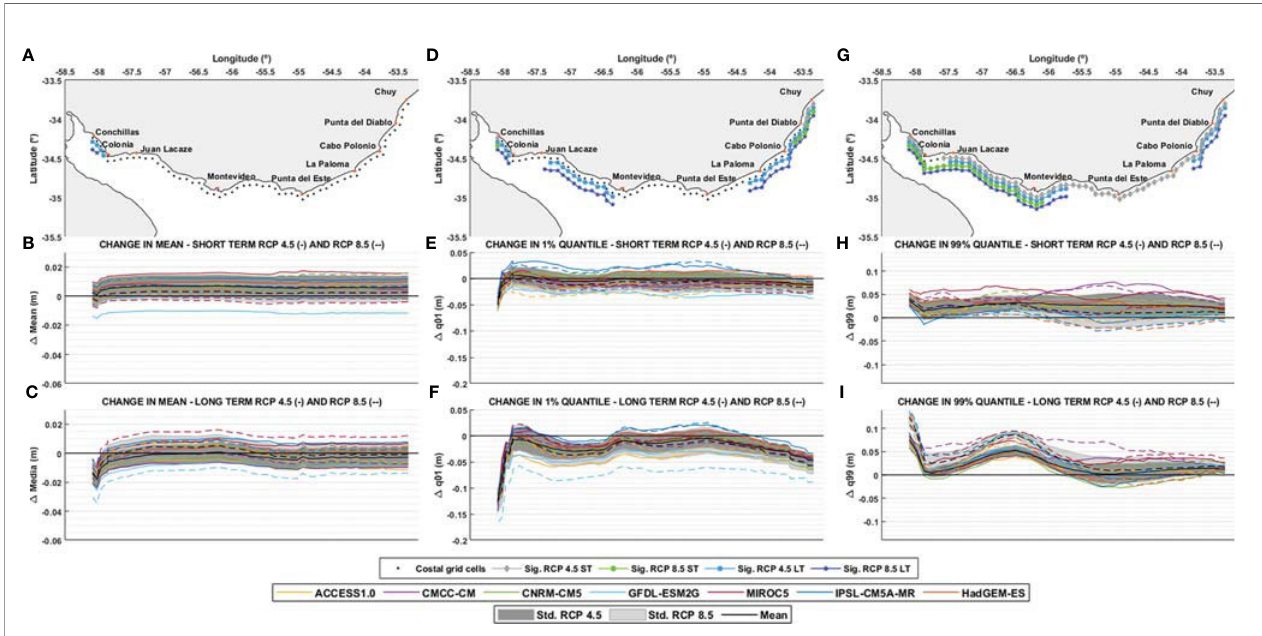
FIGURE 9 | Change in mean (A – C) , change in 1% quantile (D – F) and change in 99% quantile (G – I) of SLWR obtained from local model forced with each GCM and ensemble (black), along the coast for short (2026-2045) and long term (2082-2100) and for RCP 4.5 (continuous lines) and RCP 8.5 (dotted lines). E.g.: change in 99% quantile for the short term is calculated as the difference between 2045-2026 99% quantile and 1986-2005 99% quantile. (A, D, G) : coastal grid cells and signi fi cance for the ensemble change for each scenario (the symbol indicates statistical signi fi cance of the ensemble change). (B, E, H) : change for short term. (C, F, I) : change for long